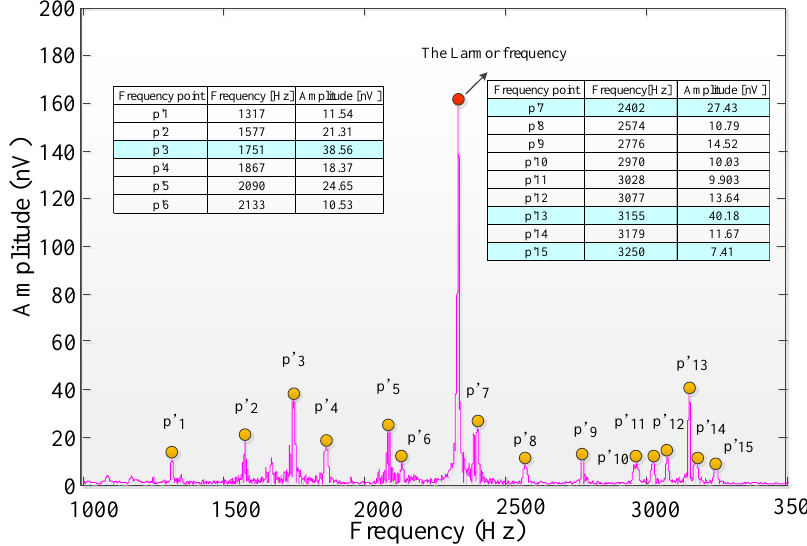
Figure 13. Comparison of residual noise and MRS signal by DA-MFSS.